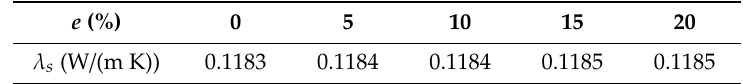
Table 1. Influence of stochastic error in the measured data on the identified conductivity of nanometer-sized skeleton.